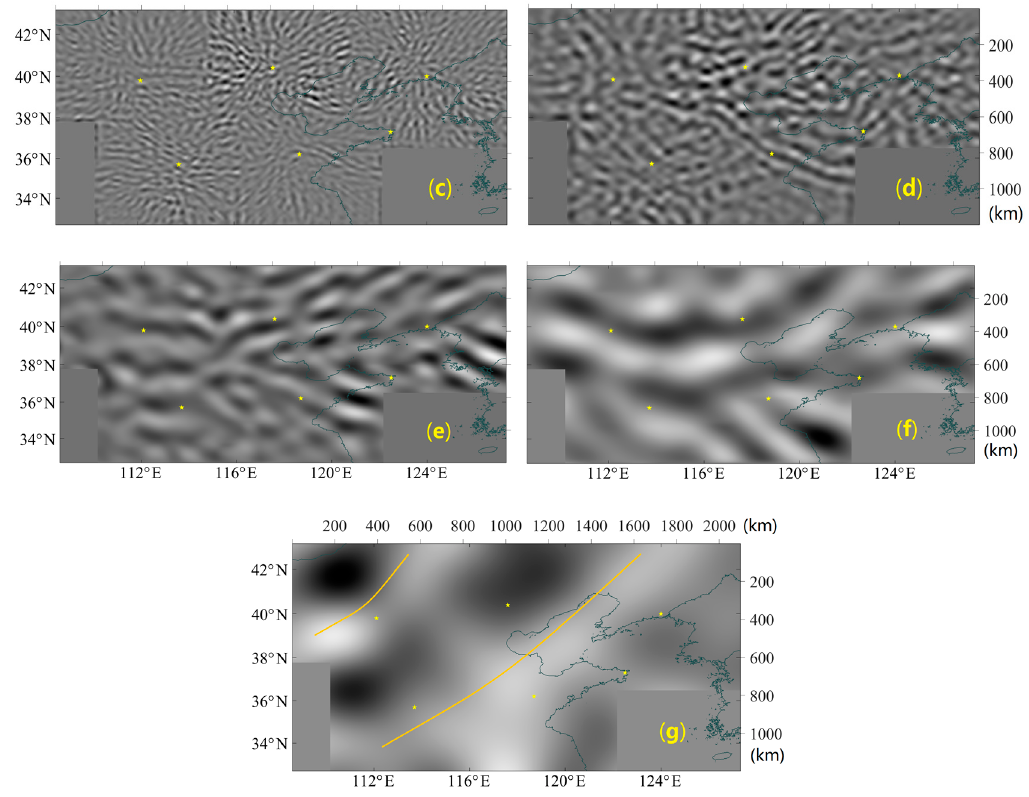
Figure 5. The peeled layers from the original image. The axes above and to the right represent the position. The lower and left axes indicate the longitude and latitude, respectively. The ASAI stations are marked with yellow points. Every peeled layer is denoised by a band filter to enhance the wave pattern. ( a ) Sum of the first three layers ( n = 1, 2, 3), mainly noise; ( b ) 4th layer, ripples are marked in the image; ( c – f ) 5–8th layers, waves reconstructed by basis vector with the scale of 5–8 power of 2 pixels (kilometers in reality); and ( g ) 9th layer, medium-scale gravity wave (GW) propagating to the southeast, marked by orange curves. The one-hour evolutions of GWs at di ff erent layer can be seen in the videos in Supplementary Materials.